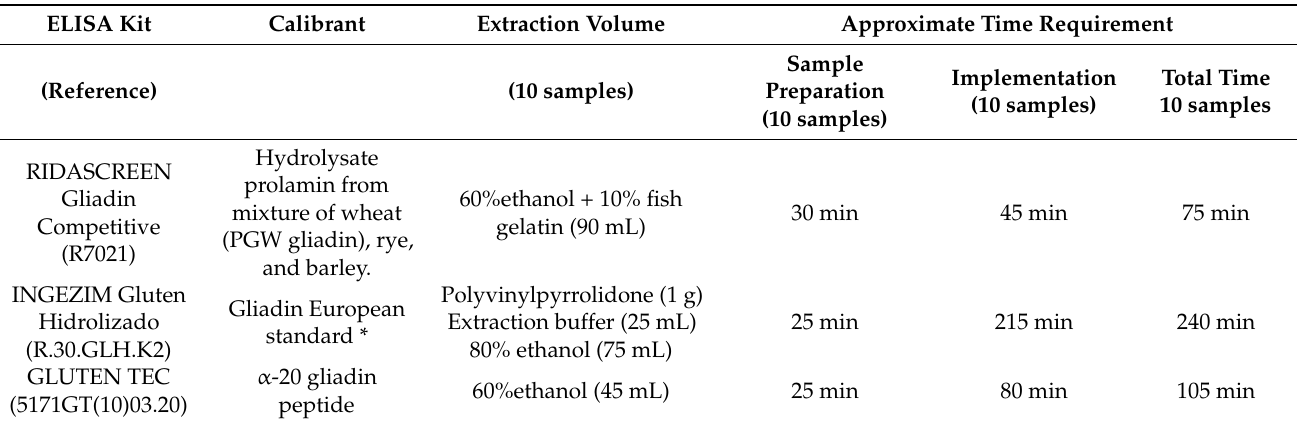
Table 2. Manufacturer’s specified properties of gluten/gliadin